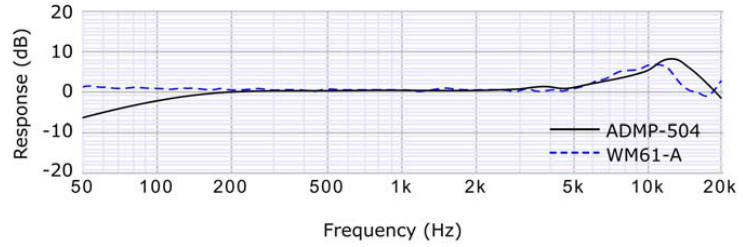
Figure 3. Frequency response of different microphones.